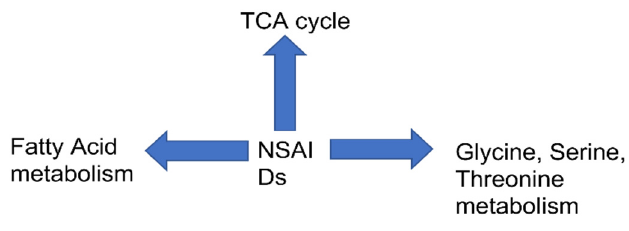
Figure 2. Global metabolic perturbation in host by